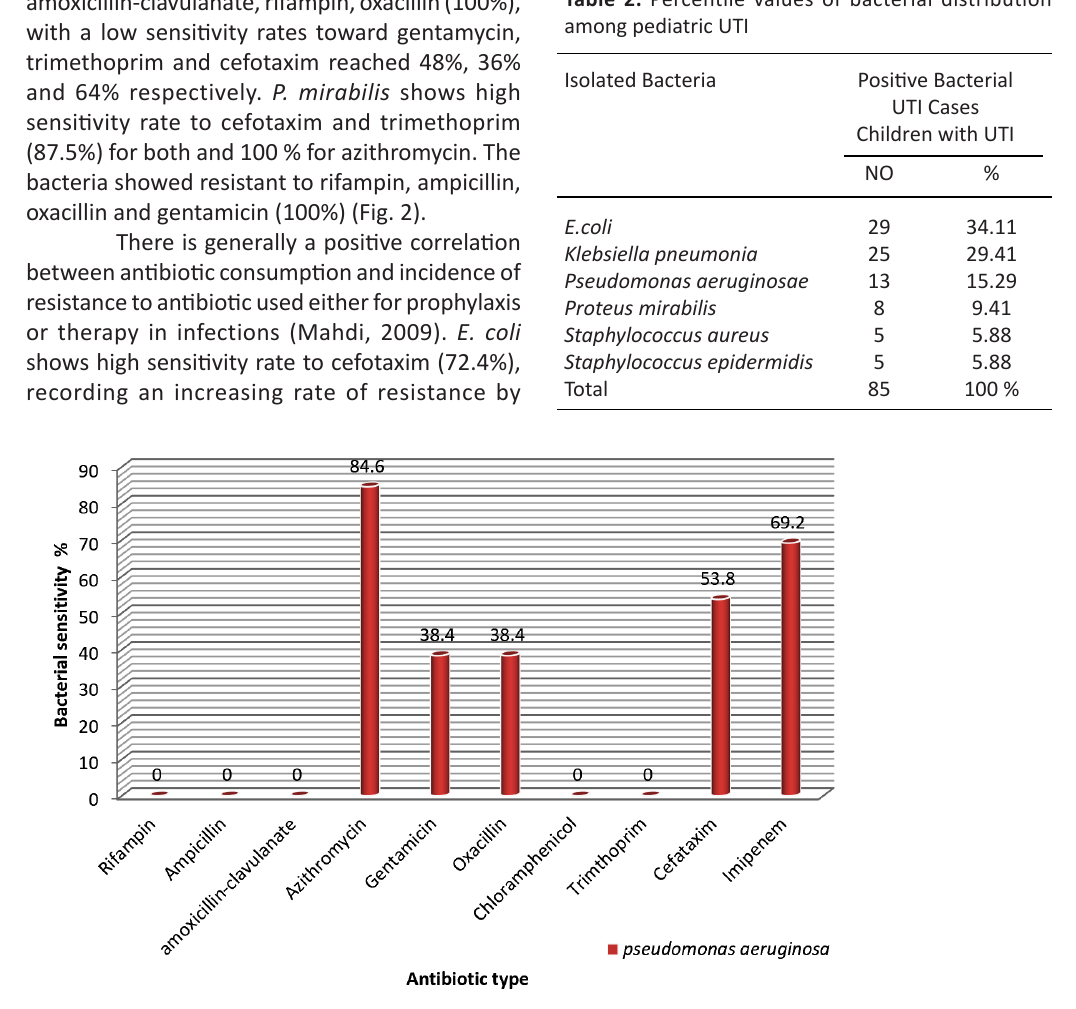
Table 2. Percentile values of bacterial distribution